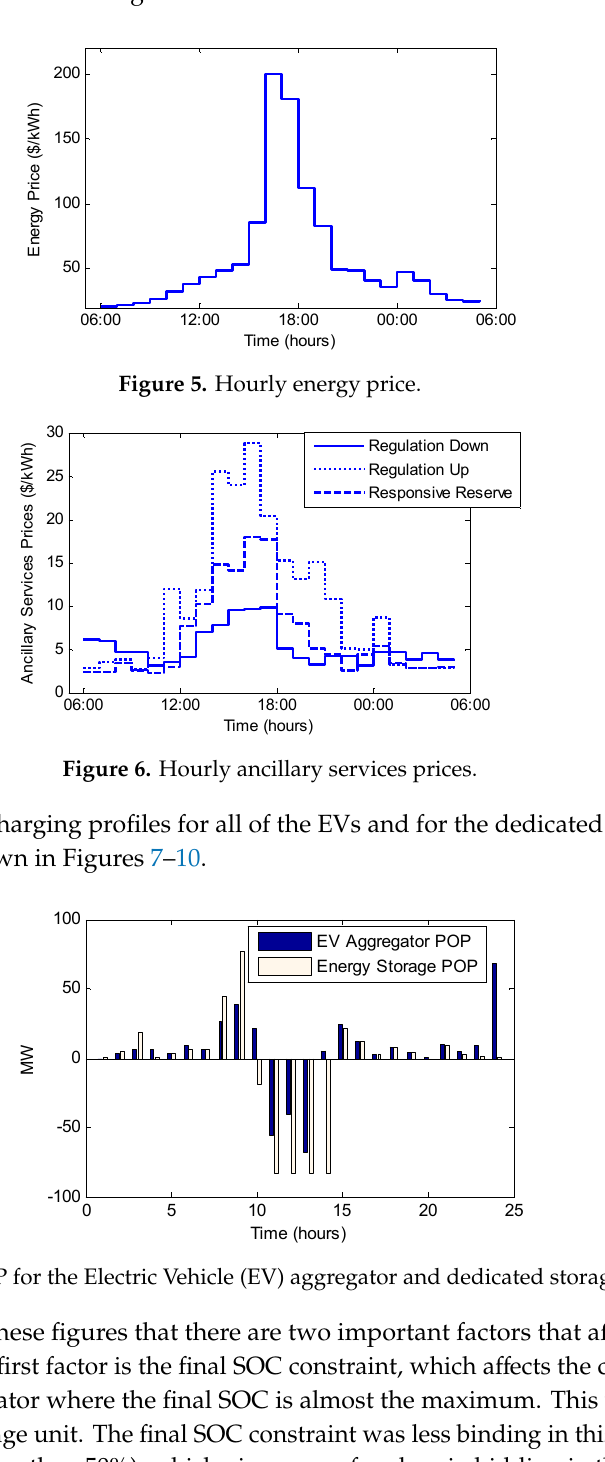
Figure 8. Regulation down capacity of the EV aggregator and dedicated storage unit.